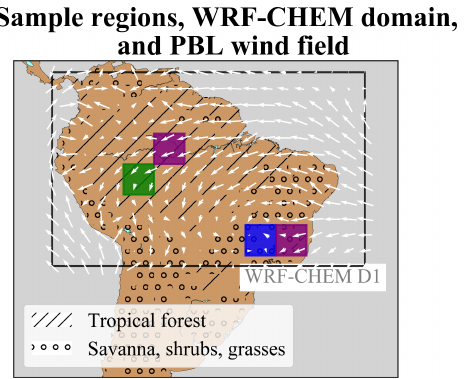
Figure 4. Location of the deforestation 5 ◦ × 5 ◦ sampling region (green), the savanna 5 ◦ × 5 ◦ sampling region (blue) and two back- ground regions adjacent to the two source regions (purple). The WRF-Chem domain and the predominant wind direction in the PBL during the 2018 fire season are superimposed. The location of the green region is also used to sample X CO and X NO 2 data from four WRF-Chem simulations (see Sect.